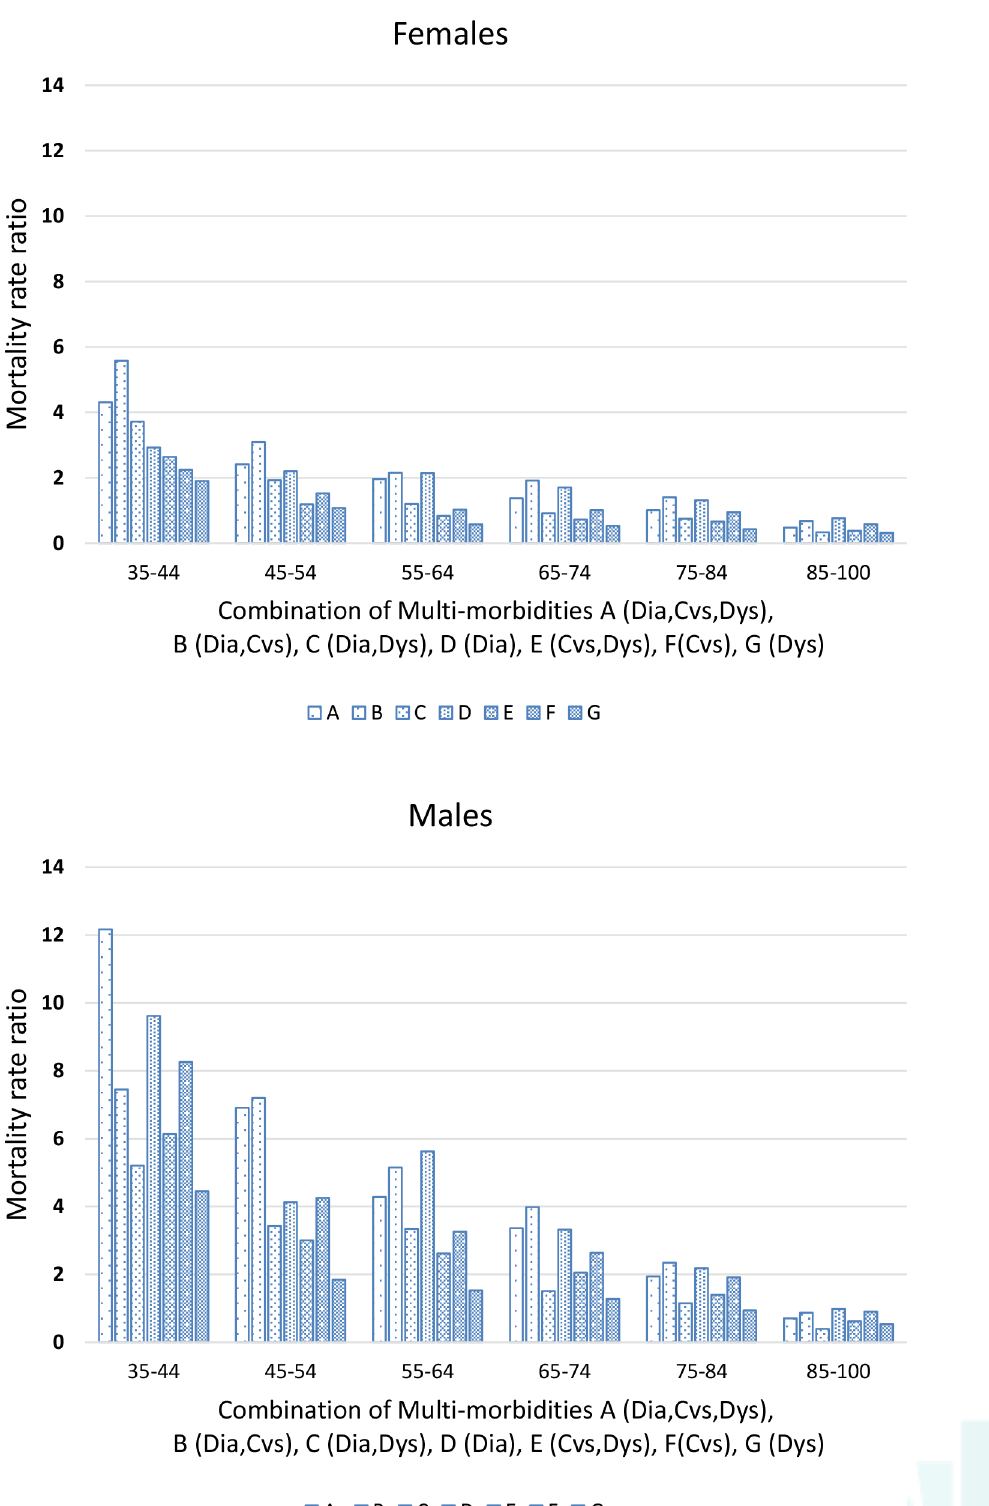
Figure 1: Mortality rate ratios for females and males with diabetes associated multi-morbidities of age groupings > 35 years